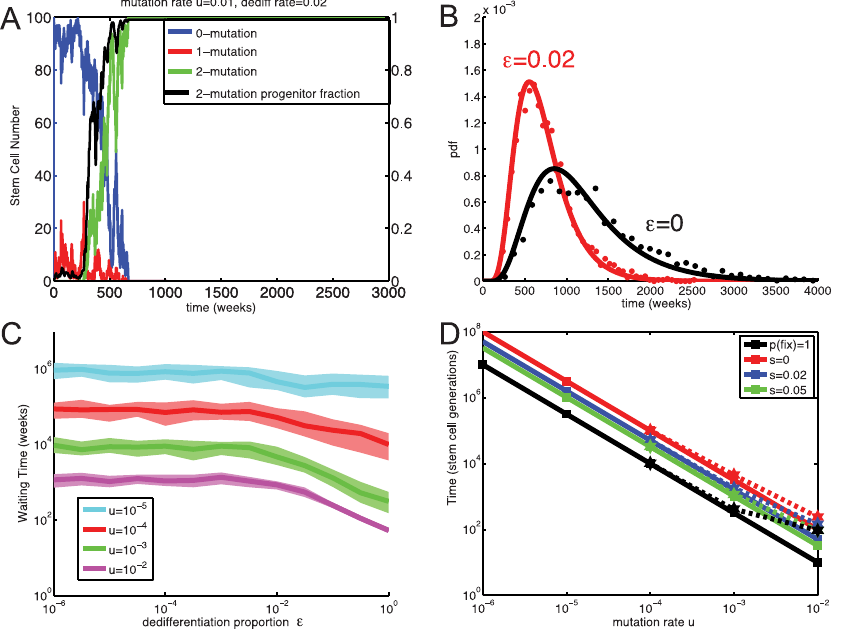
Figure 4. Times to fixation with dedifferentiation for constant stem cell population size. (A) Typical simulation trajectory with dedifferentiation ( e ~ 0 : 02 ) for the same random number seed as Fig. 3A. Blue: zero-mutation stem cells, Red: one-mutation stem cells, Green: two- mutation stem cells. Black: proportion of two-mutation cells in the progenitor population. (B) Distributions of times to fixation of two-mutation cells under strict stem cell homeostasis. Normalized histograms (dots) and analytical approximations (solid lines) are shown for u ~ 0 : 01 for zero dedifferentiation (red; e ~ 0 ) and non-zero dedifferentiation (black; e ~ 0 : 02 ). (C) Median times to fixation of two-mutation cells (solid lines) and inter- quantile ranges (shaded regions) versus dedifferentiation rate e and mutation rate u . (D) Mean times to emergence of a successful two-mutation stem cell (solid lines, Eq. (9)) and fixation of such cells (dotted lines, Eq. (12)) in Moran models with selection coefficient s . Black curve indicates first appearance of two-mutant cell.